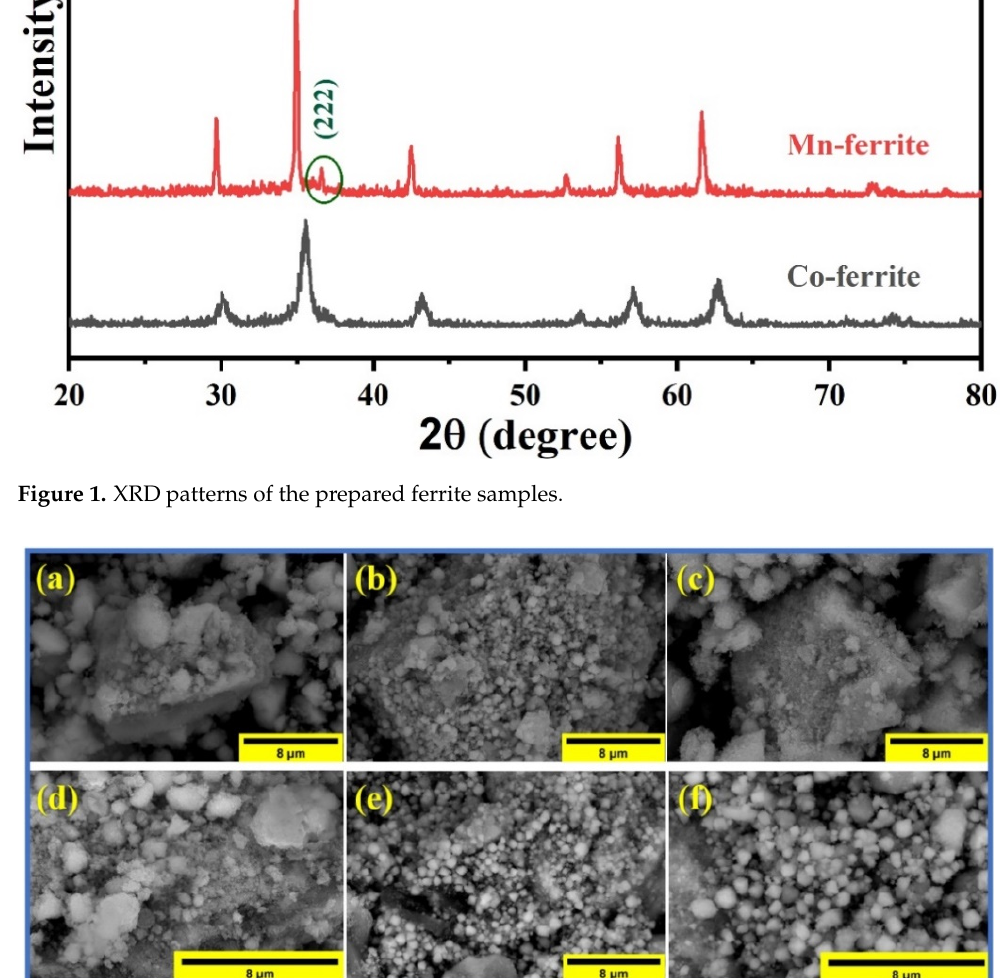
Table 1. Average particle size calculated from the XRD patterns and SEM images.